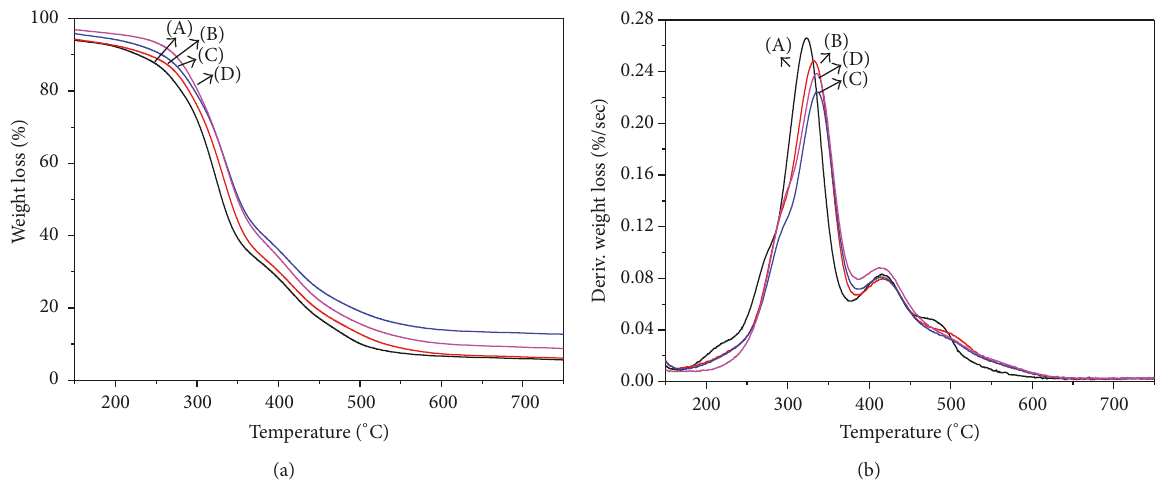
Figure 4: TG and DTG cures of (A) pure polyol, (B) 5% lignin, (C) 10% lignin, and (D) 15% lignin content polyurethane foams.